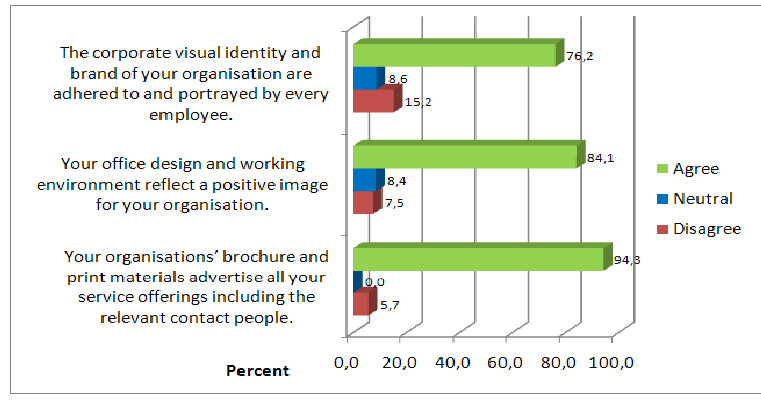
Fig. 6. Respondent scores: